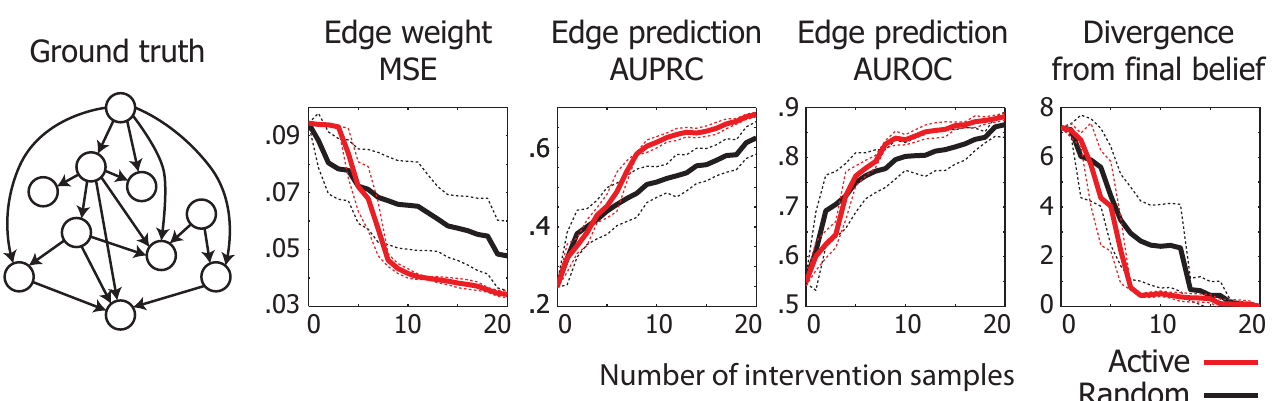
Fig 3. Reconstruction performance on simulated data from a GBN. We compared edge prediction performance between active and random learners, summarized over five trials. The dotted lines are drawn at one standard deviation from the mean in each direction. Active learner achieves higher accuracy and faster convergence than random